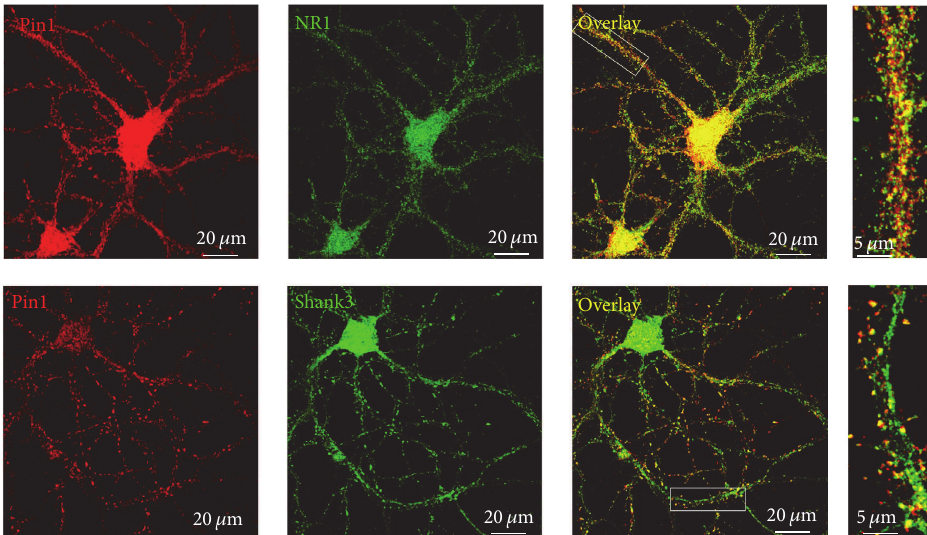
Figure 2: Pin1 proteins are partly colocalized with Shank3 and NR1 proteins at dendritic spines of neurons. Cortical neurons at 21 DIV were double immunolabeled for Pin1 (red) and Shank3 (green) or NR1 (green). When the images were merged, the yellow in the overlay showed colocalization of Pin1-immunoreactive puncta with Shank3 and NR1 proteins. Right panels were high-magnification images of selected overlays.